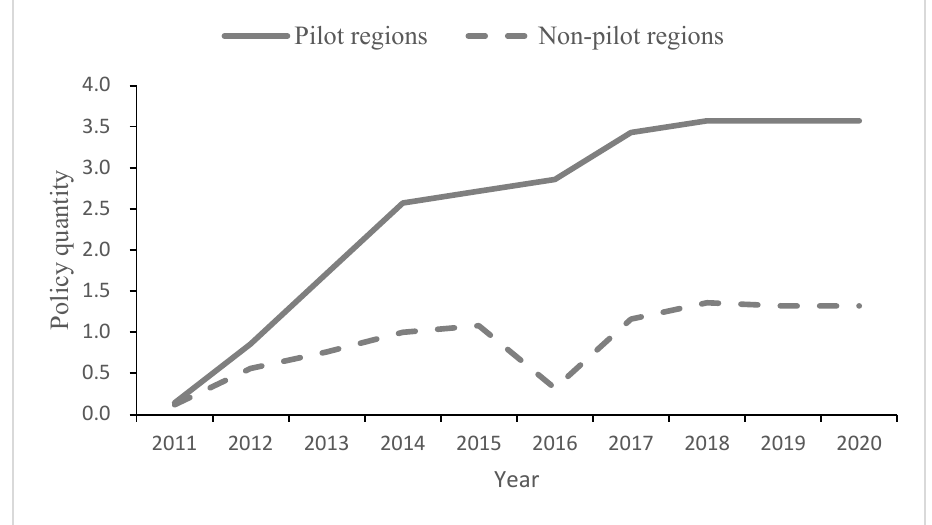
Figure 2. Policy quantity of CET in pilot and non-pilot regions (2011–2020). (Note: the data supporting the figure were calculated by the authors).